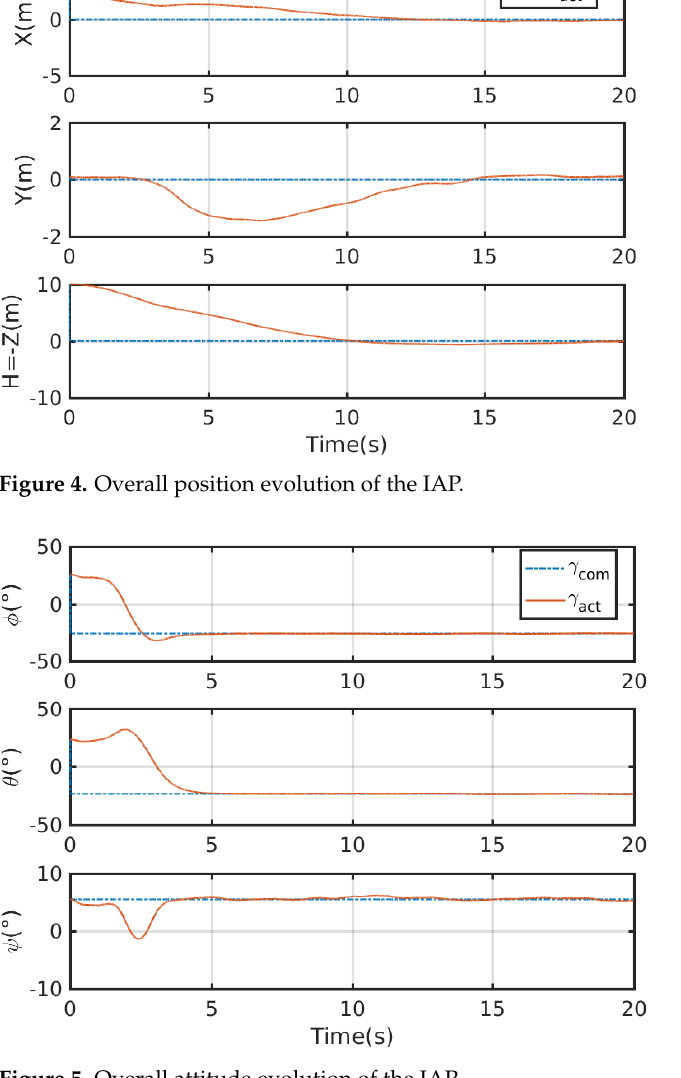
Figure 5. Overall attitude evolution of the IAP.